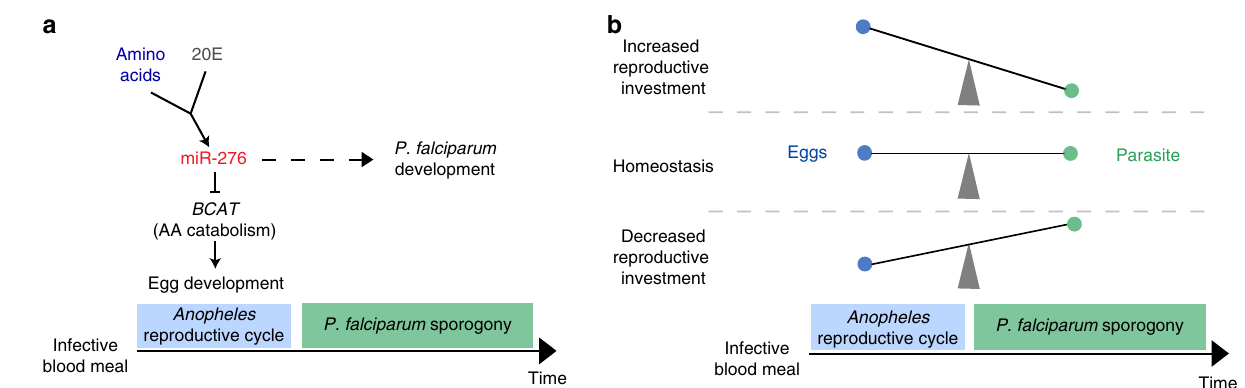
Fig. 5 Summary of miR-276 function and model of mosquito reproductive investment and P. falciparum development interaction. a Amino acids (AA) and 20-hydroxyecdysone (20E) induce expression of miR-276 after blood feeding and, thereby, initiate the termination of the fat body AA catabolism by inhibiting the branched chain amino acid transferase ( BCAT ). This catabolism to anabolism switch in the fat body restricts mosquito investment into reproduction. P. falciparum sporogonic stages parasitize spare mosquito resources for their own development. b Mosquito nutritional status and the extent of the reproductive investment shape the within-vector environment which shapes P. falciparum sporogonic